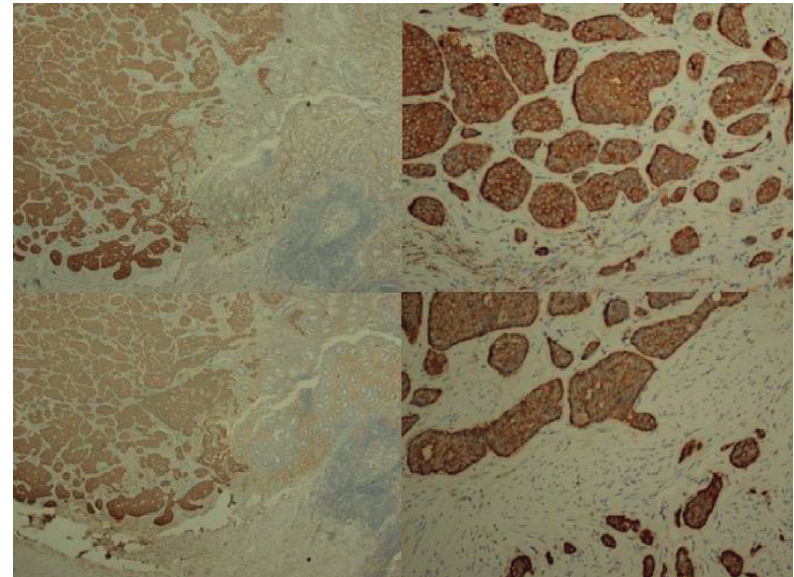
Figure 7: Synaptophysin and chromogranin A are positive in tumor tissue in the immunohistochemical